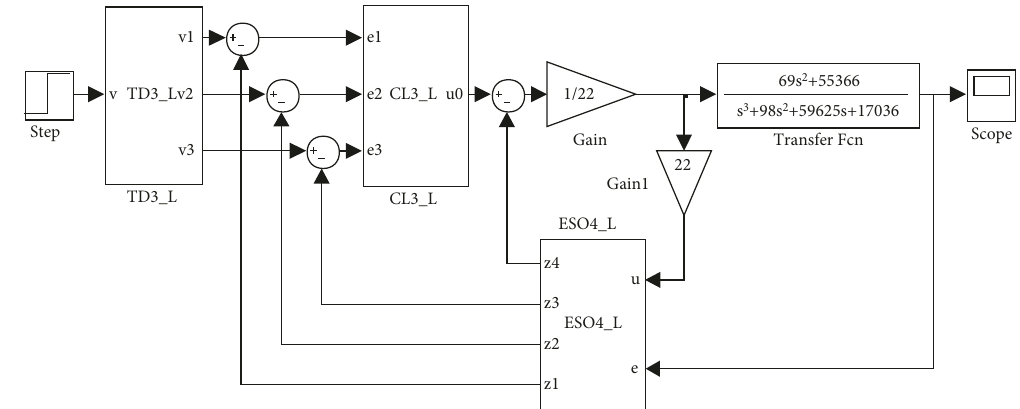
Figure 18: Simulation model of control system self-immunity control.